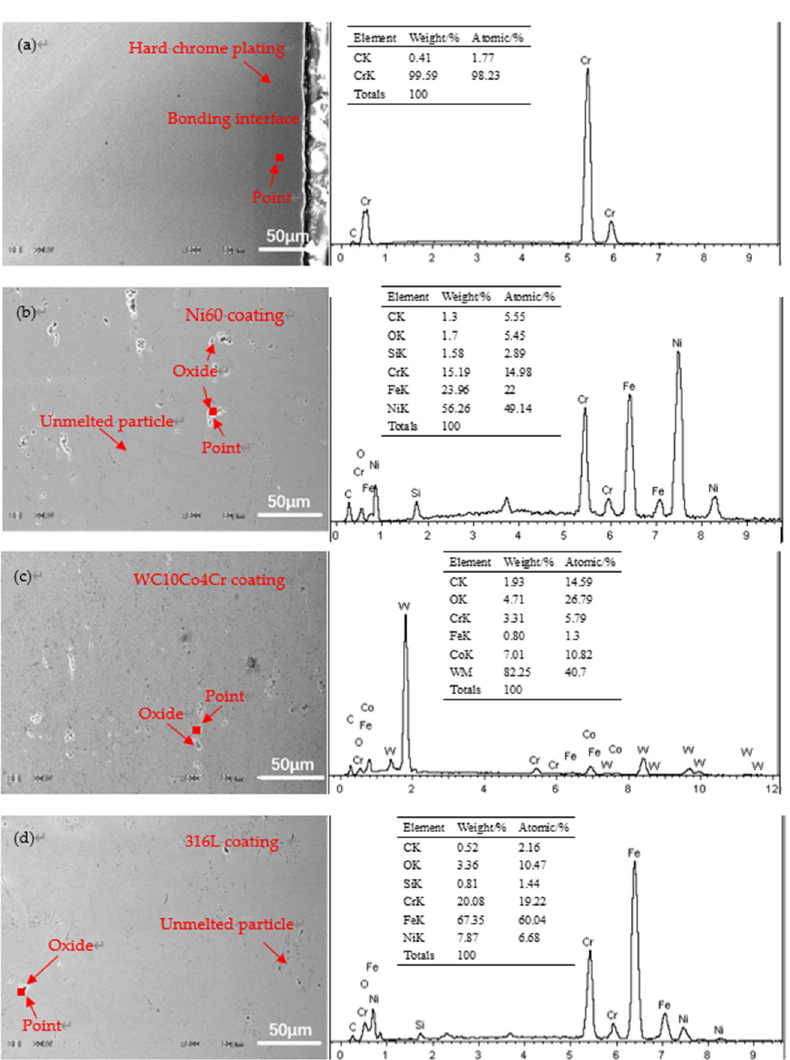
Figure 5. Microstructure and EDS of hard chrome plating and HVOF coatings. ( a ) hard chrome plating, (b) Ni60 coating, ( c ) WC10Co4Cr coating, ( d ) 316L coating.